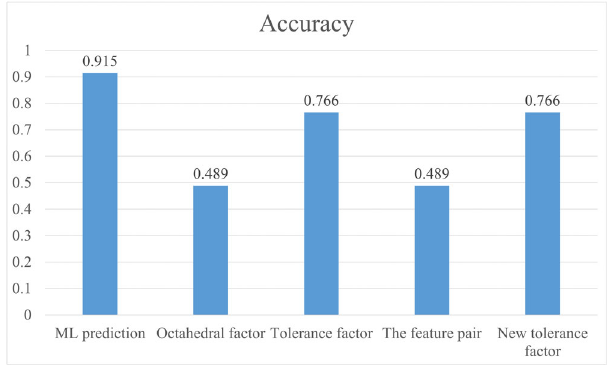
Fig. 7 The comparison in accuracy between traditional methods and machine learning prediction with fi ve features. The feature pair refers to using both octahedral factor and tolerance factor for the